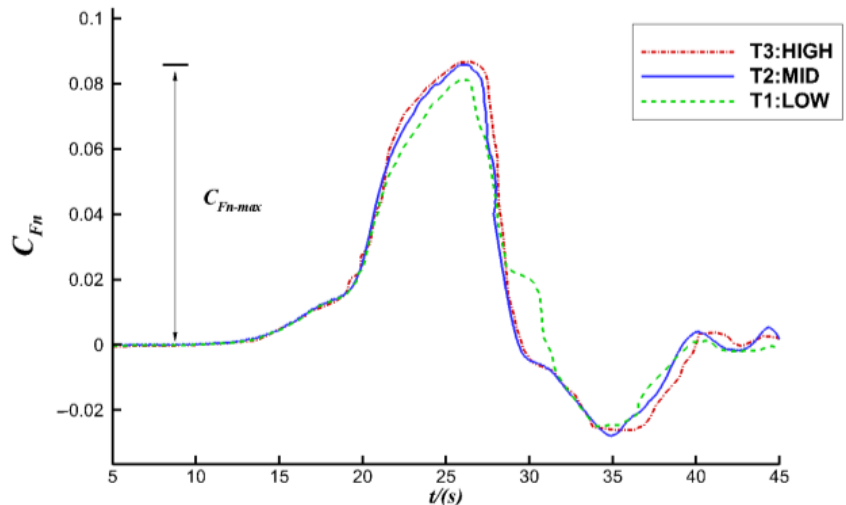
Figure 5. Numerical model verification results of the IWs forces on a cylinder of different mesh densities, ƞ 0 /H = 0.0575.